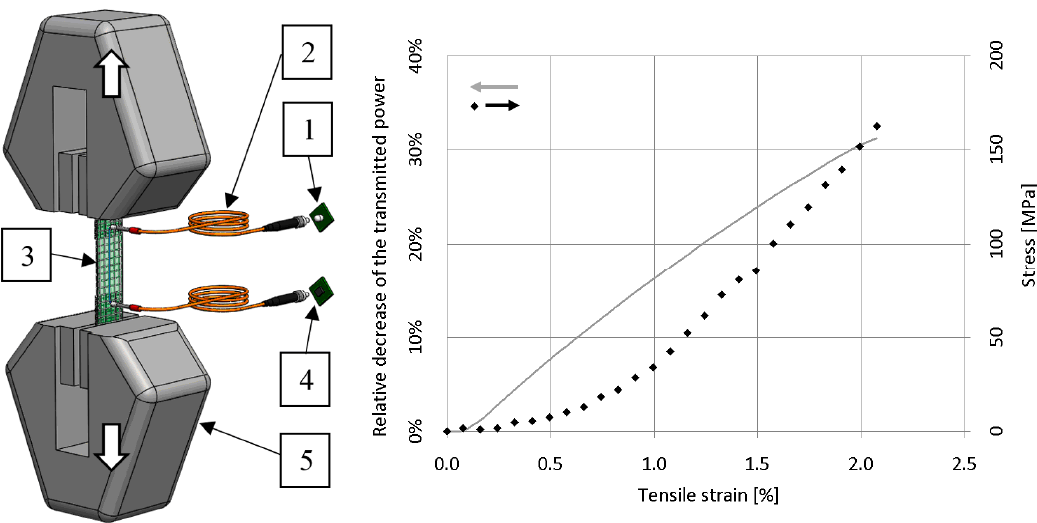
Figure 5. Tensile measurement layout (1: light source, 2: signal transmitter (polymer optical fibre), 3: specimen, 4: photodiode, 5: clamp of the tensile machine) and a typical plot.